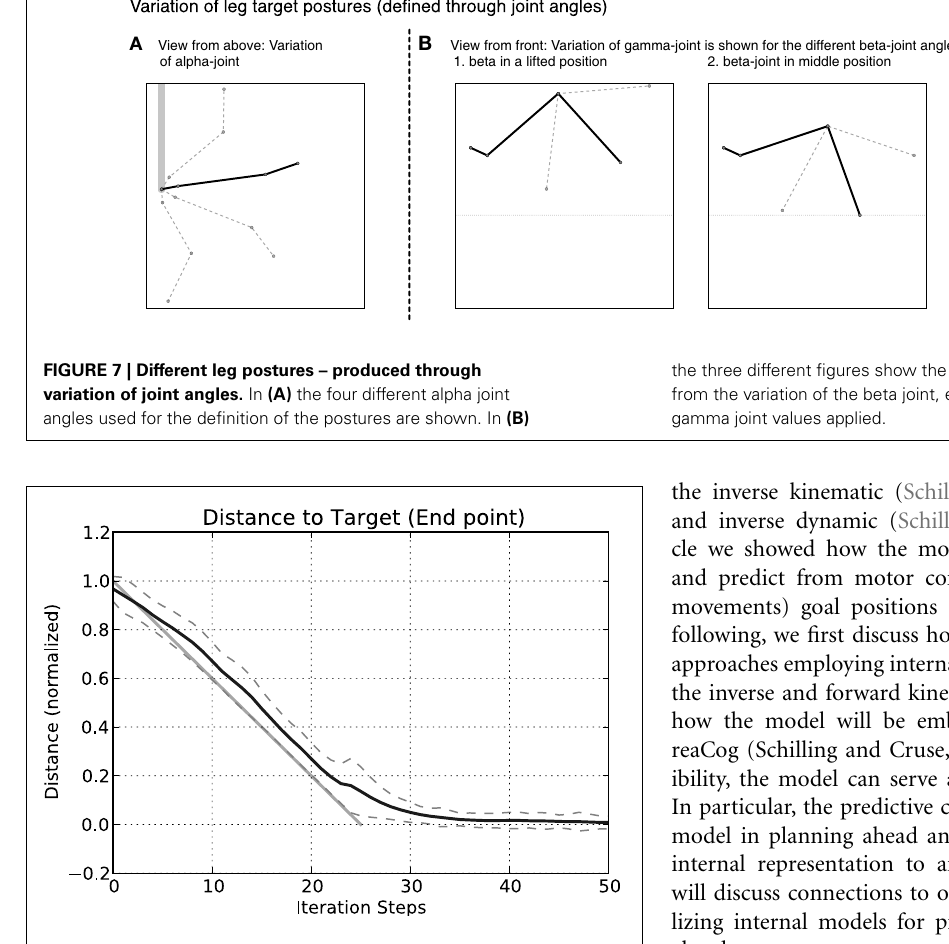
FIGURE 8 | Distance of the estimated leg end position to the position of the target posture in three-dimensional space over time. The mean normalized distance is calculated for all 1260 movements for each iteration step.The distances are normalized with respect to the distance between start and end posture in three-dimensional space (dashed lines show the SD around the mean value).The light gray line indicates a linear interpolation between the start and the target position (Importantly, the interpolation is done in joint space with a constant velocity. As a result, the interpolation of a single movement is better described by a curve (a geodesic), but over all movements we use a straight line as a simplification to indicate the general expected movement